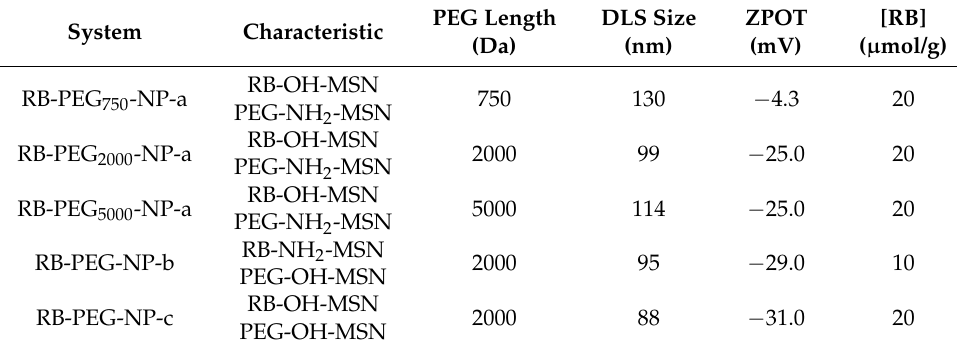
Table 2. RB amount, nanoparticle size and their Zeta potential by DLS in water of the different